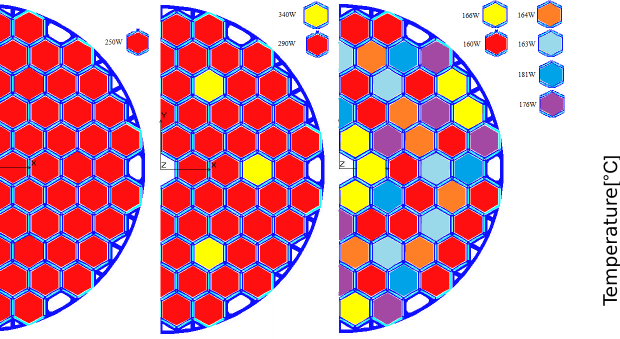
Figure 7. The reference homogeneous pattern for CASTOR 440/84 (left), reference heterogeneous pat- tern for CASTOR 440/84M (center) and the initial pattern of the real SC CASTOR 440/84 No.10 from the SFSNF (right)